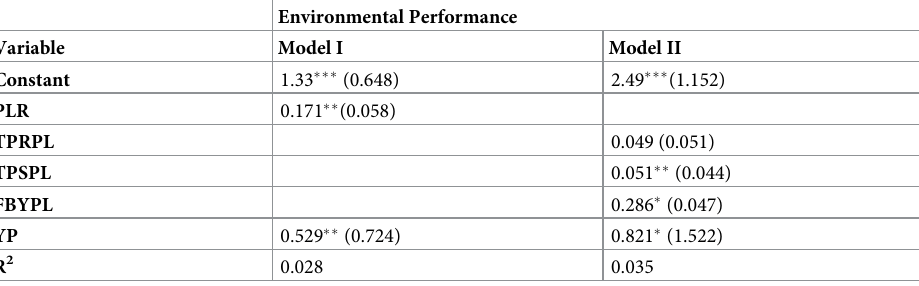
Table 2. Impact of political reforms on environmental performance.